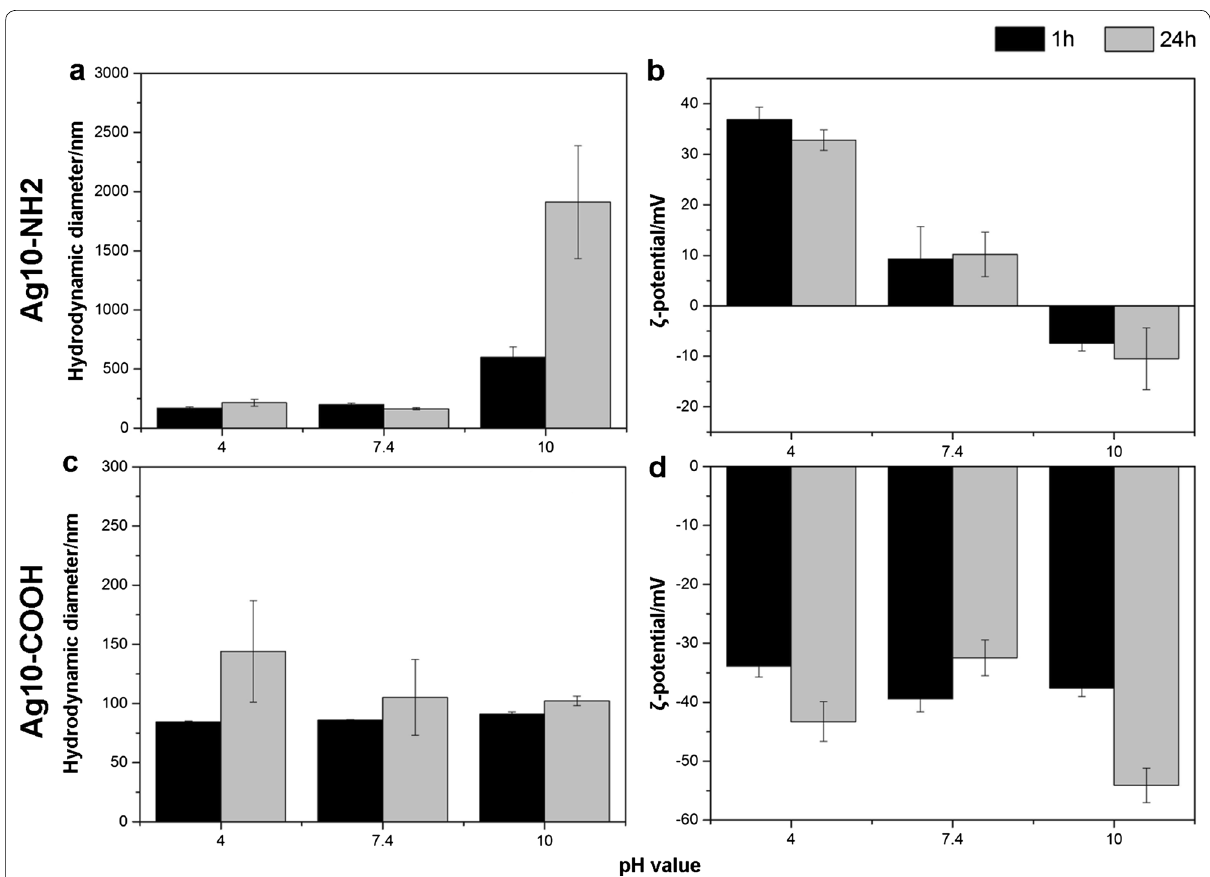
Fig. 2 PH‑dependent hydrodynamic diameter and ζ ‑potential of Ag10‑COOH ( a , b ) and Ag10‑NH 2 ( c , d ). N